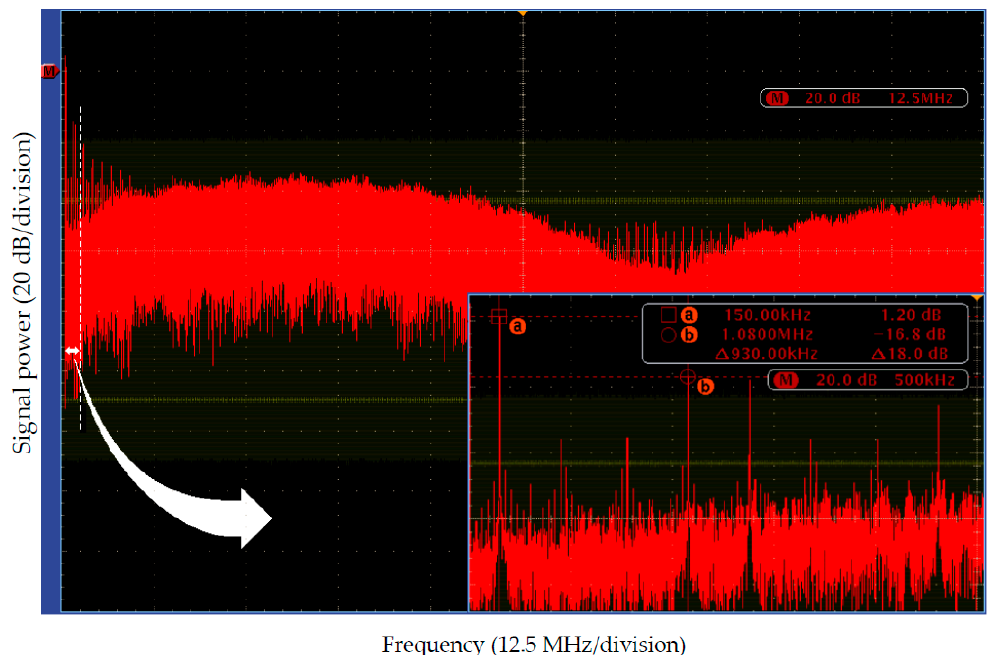
Figure 5. Spectrum (signal power in dB versus frequency) of the PDM signal at the carry bit output (Figure 3), before the low-pass filter (LPF) (output frequency signal of 150 kHz). Peak ( a ) corresponds to the frequency of the sine signal; peak ( b ) is the (𝑓 (cid:3046)(cid:3028)(cid:3040)(cid:3043)(cid:3039)(cid:3036)(cid:3041)(cid:3034) − 𝑓 (cid:3042)(cid:3048)(cid:3047) ) frequency. Spectrum peaks between ( a ) and ( b ) corresponds to the 3rd and 5th harmonics of the signal. The rest of the spectrum peaks are due to the intermodal distortion.